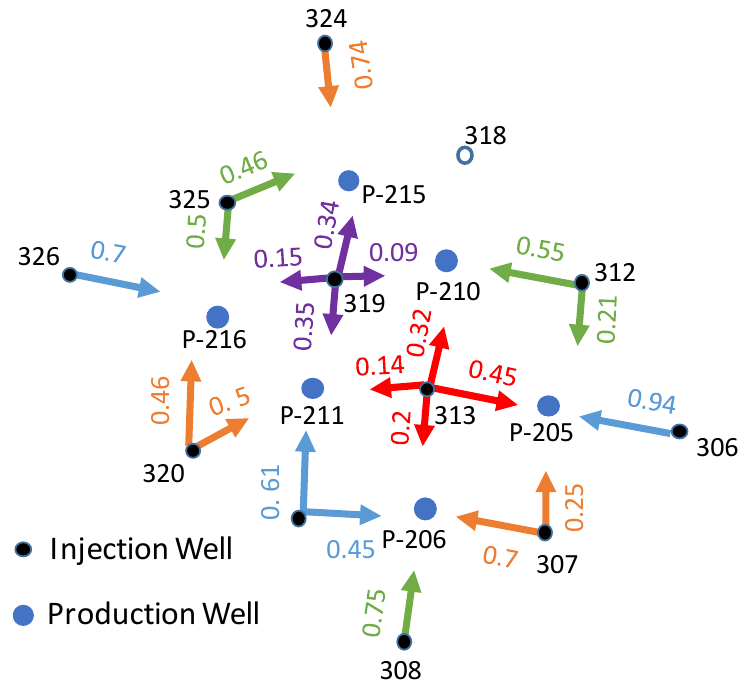
Figure A4. Extrapolated fractional recoveries for each of the injector–producer combinations (num- bers next to arrows). Well numbers are shown next to dots representing wells. Lengths of arrows have no significance.